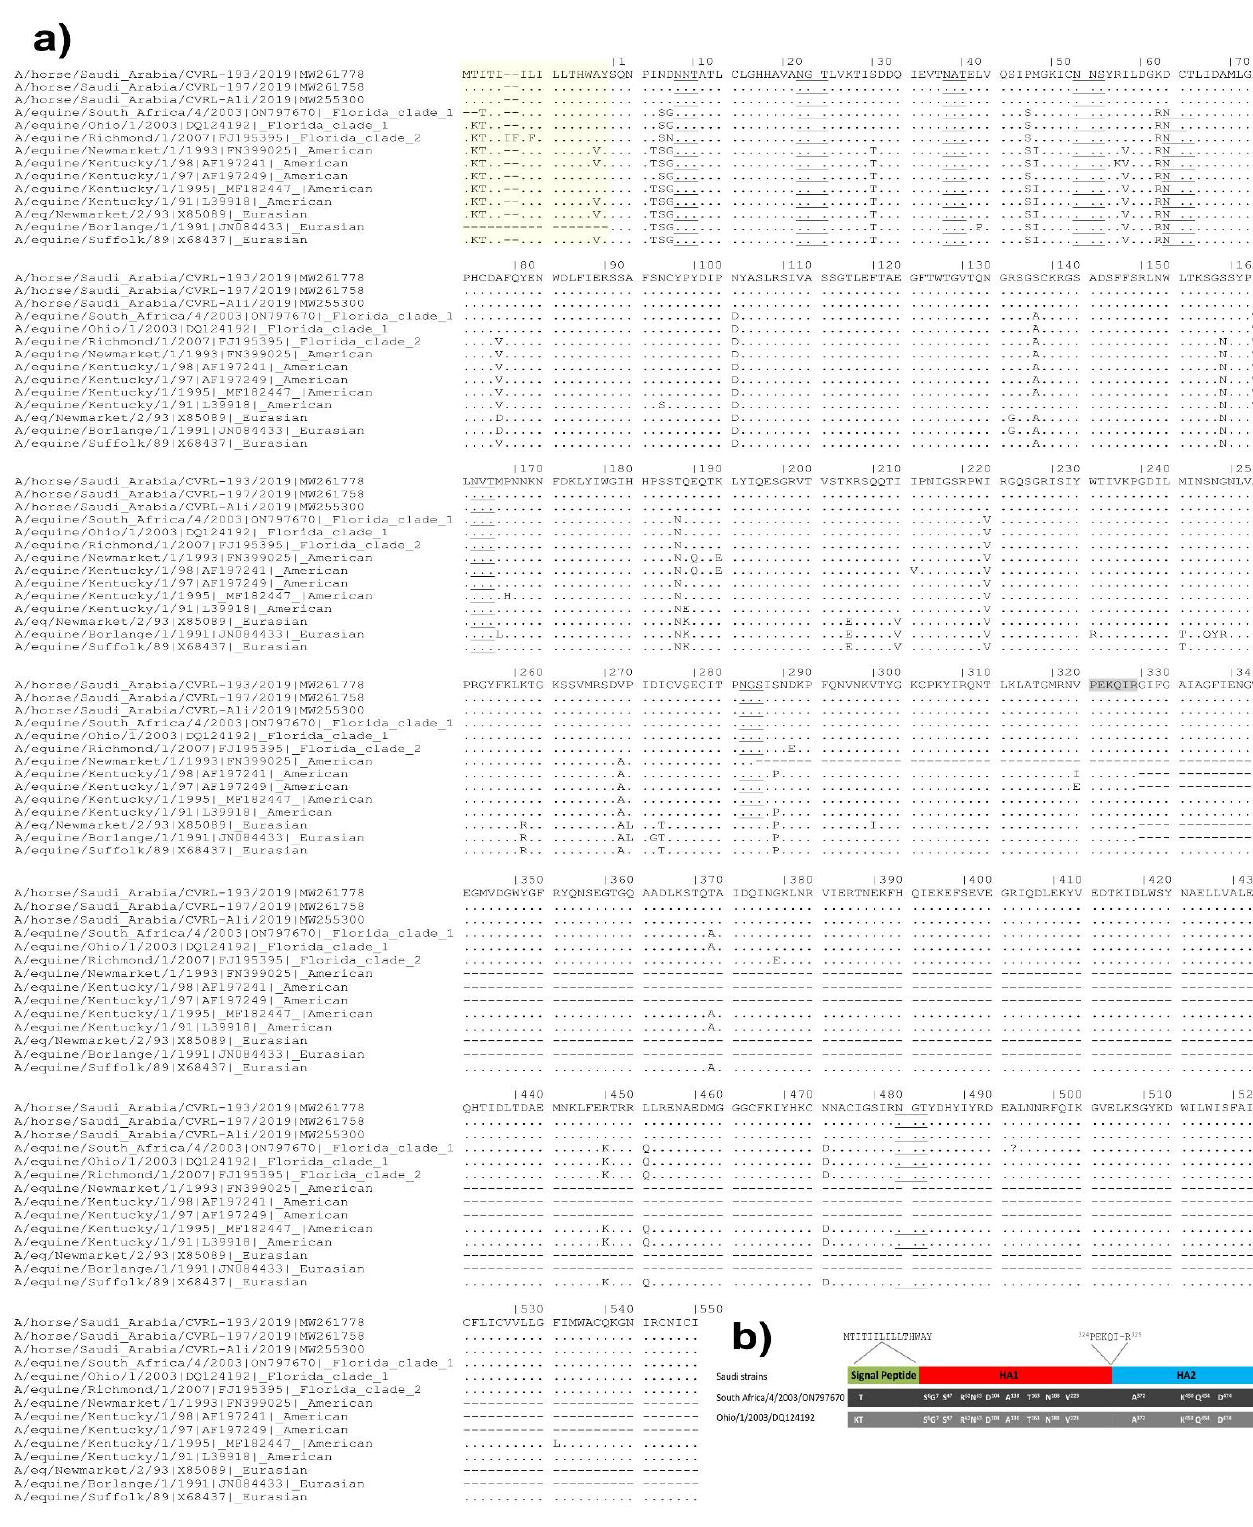
Figure 3. Deduced amino acid sequence of the hemagglutinin glycoprotein of the Saudi H3N8 equine influenza virus strains in comparison to the virus strains used for the production of H3N8 vaccines. ( a ) Deduced amino acid sequences. Dots mean identical sequences. Signal peptide is marked by yellow boxing. Polybasic cleavage site is highlighted in grey. N-glycosylated motives (NXT or NXS, except X = P) are underlined. ( b ) A schematic representation of the HA protein of Saudi strains compared to the reference strains Ohio and South Africa California clade 1 vaccine